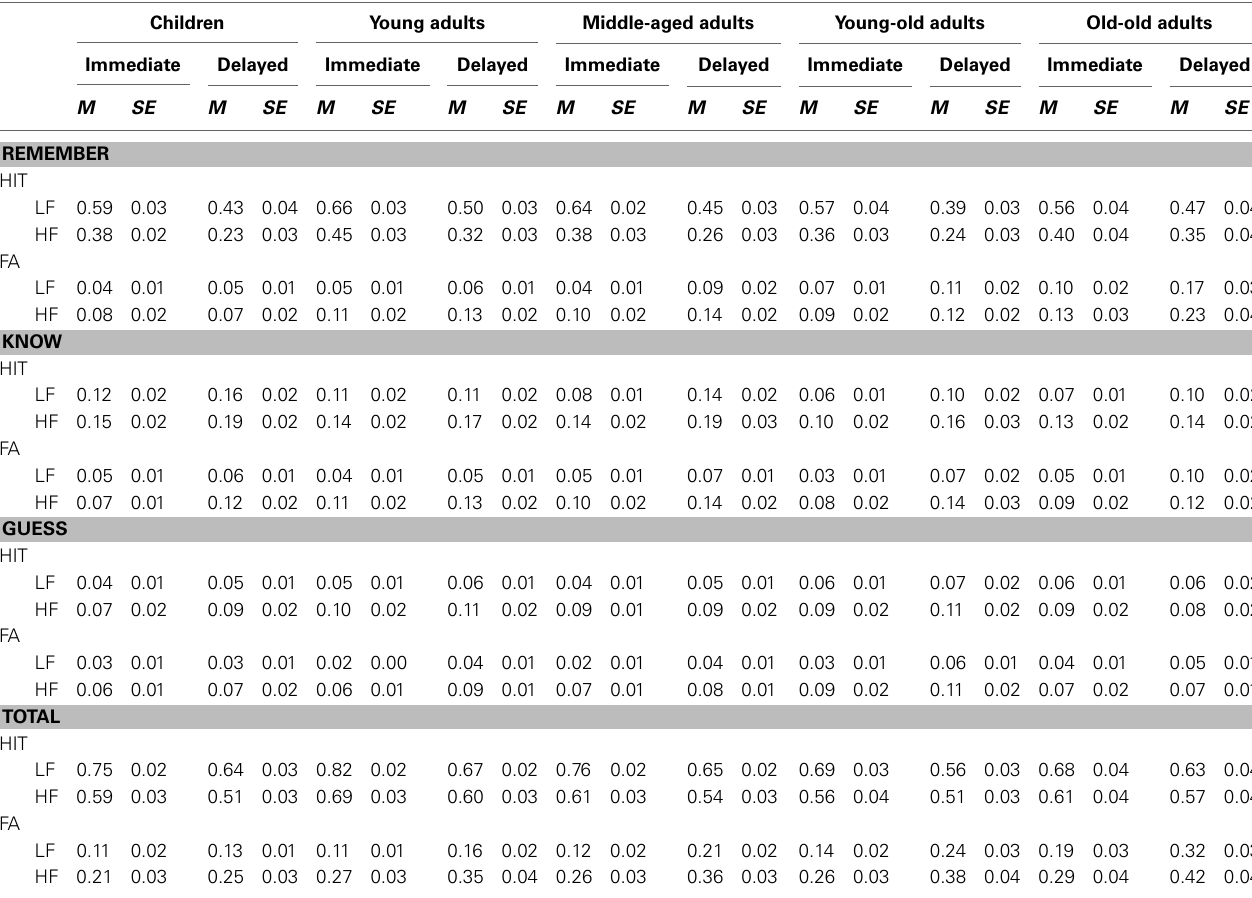
Table 4 | Experiment 3: Means and standard errors of hits and false alarm